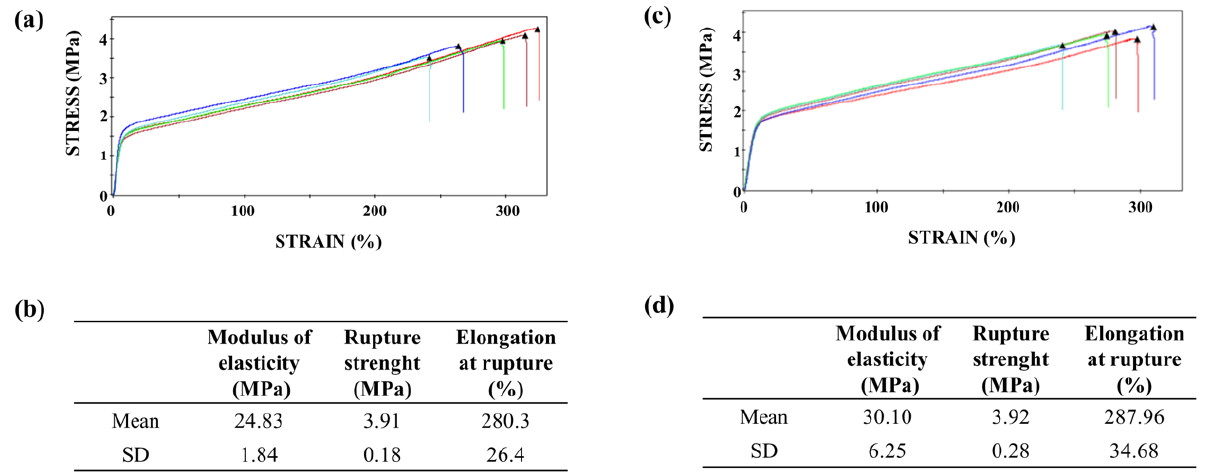
Figure 2. Mechanical traction properties. Tensile stress curves as a function of sample elongation, before ( a ) and after ( c ) the sterilization process. Mechanical properties in membrane traction, before ( b ) and after ( d ) the sterilization process. Test speed: 50